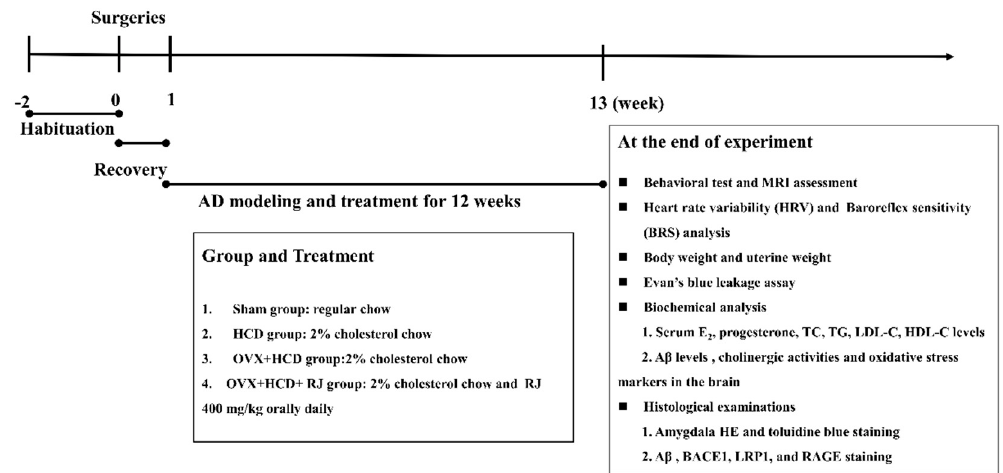
Figure 7. A flowchart of the experimental design in this Figure 7. A fl owchart of the experimental design in this study.